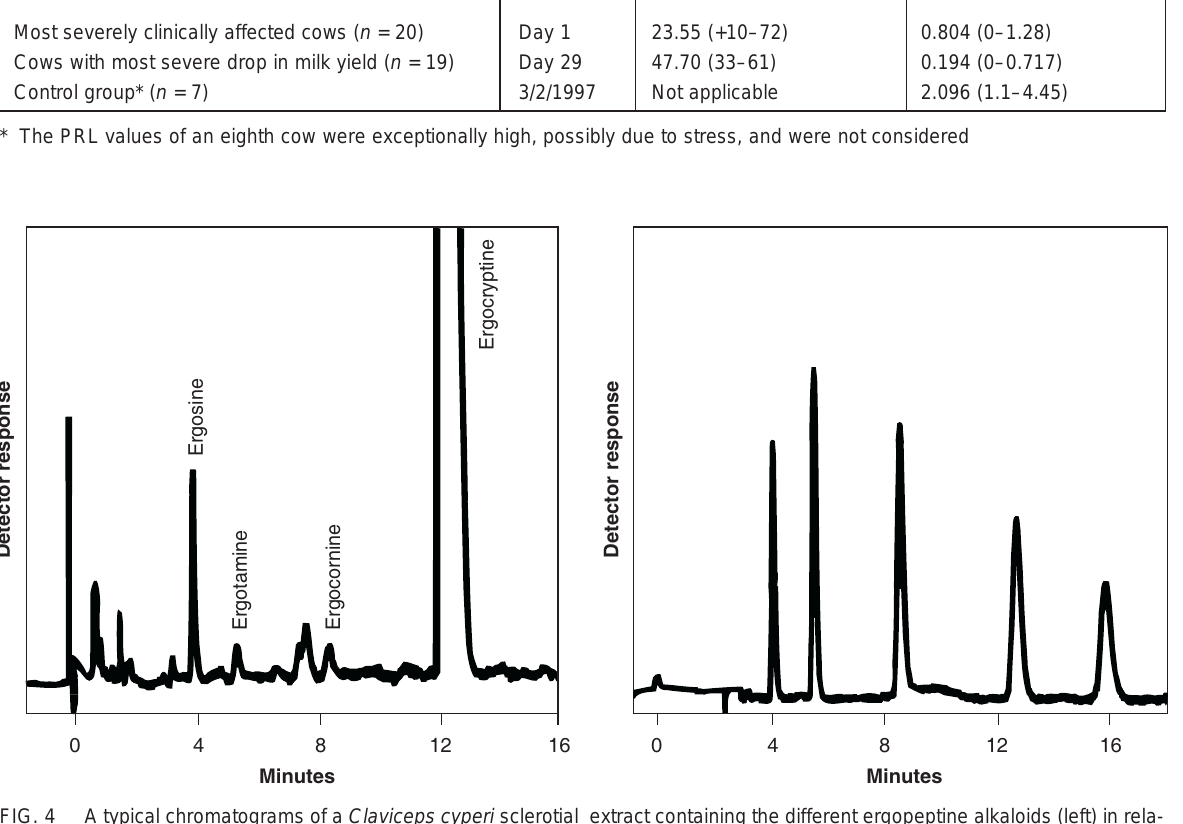
A typical chromatograms of a Claviceps cyperi sclerotial extract containing the different ergopeptine alkaloids (left) in rela- tion to that of a standard mixture (right). Note the exceptionally high